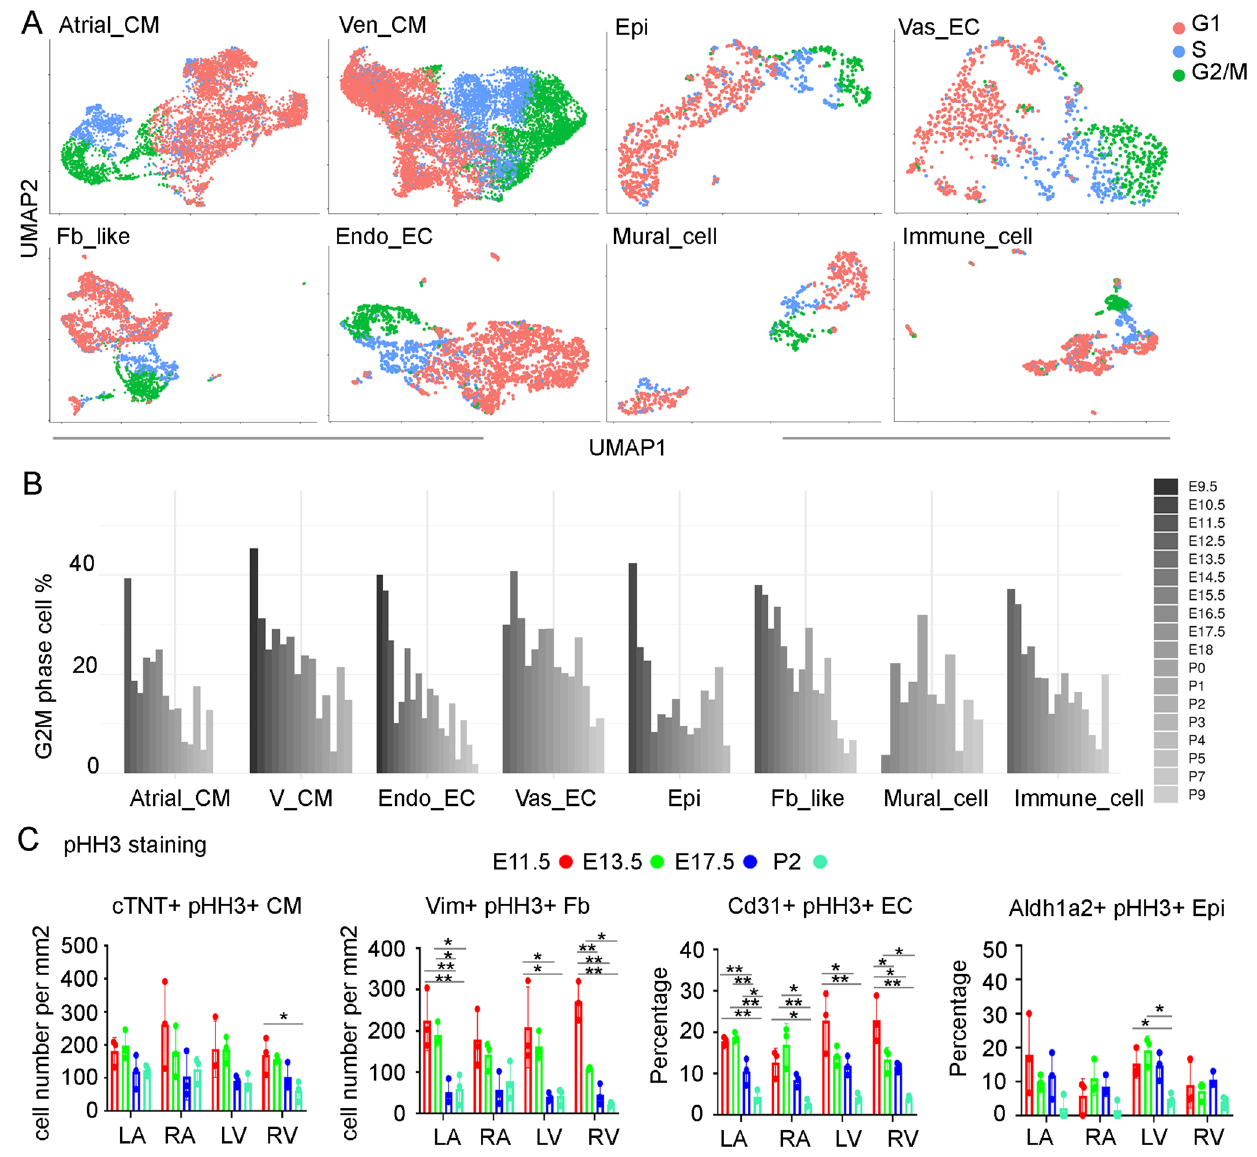
Fig.4|Analysisofcellcyclephasesineachcelltype.A UMAPofsinglecellsfrom eachcelltypelabeledbycellcyclephases. B PercentageofG2Mphasedcellsineach celltypedeclinedalongthedevelopmentalprogression. C TheproportionofpHH3 positivecellsineachcelltypedeclinedalongthedevelopmentalprogression. N